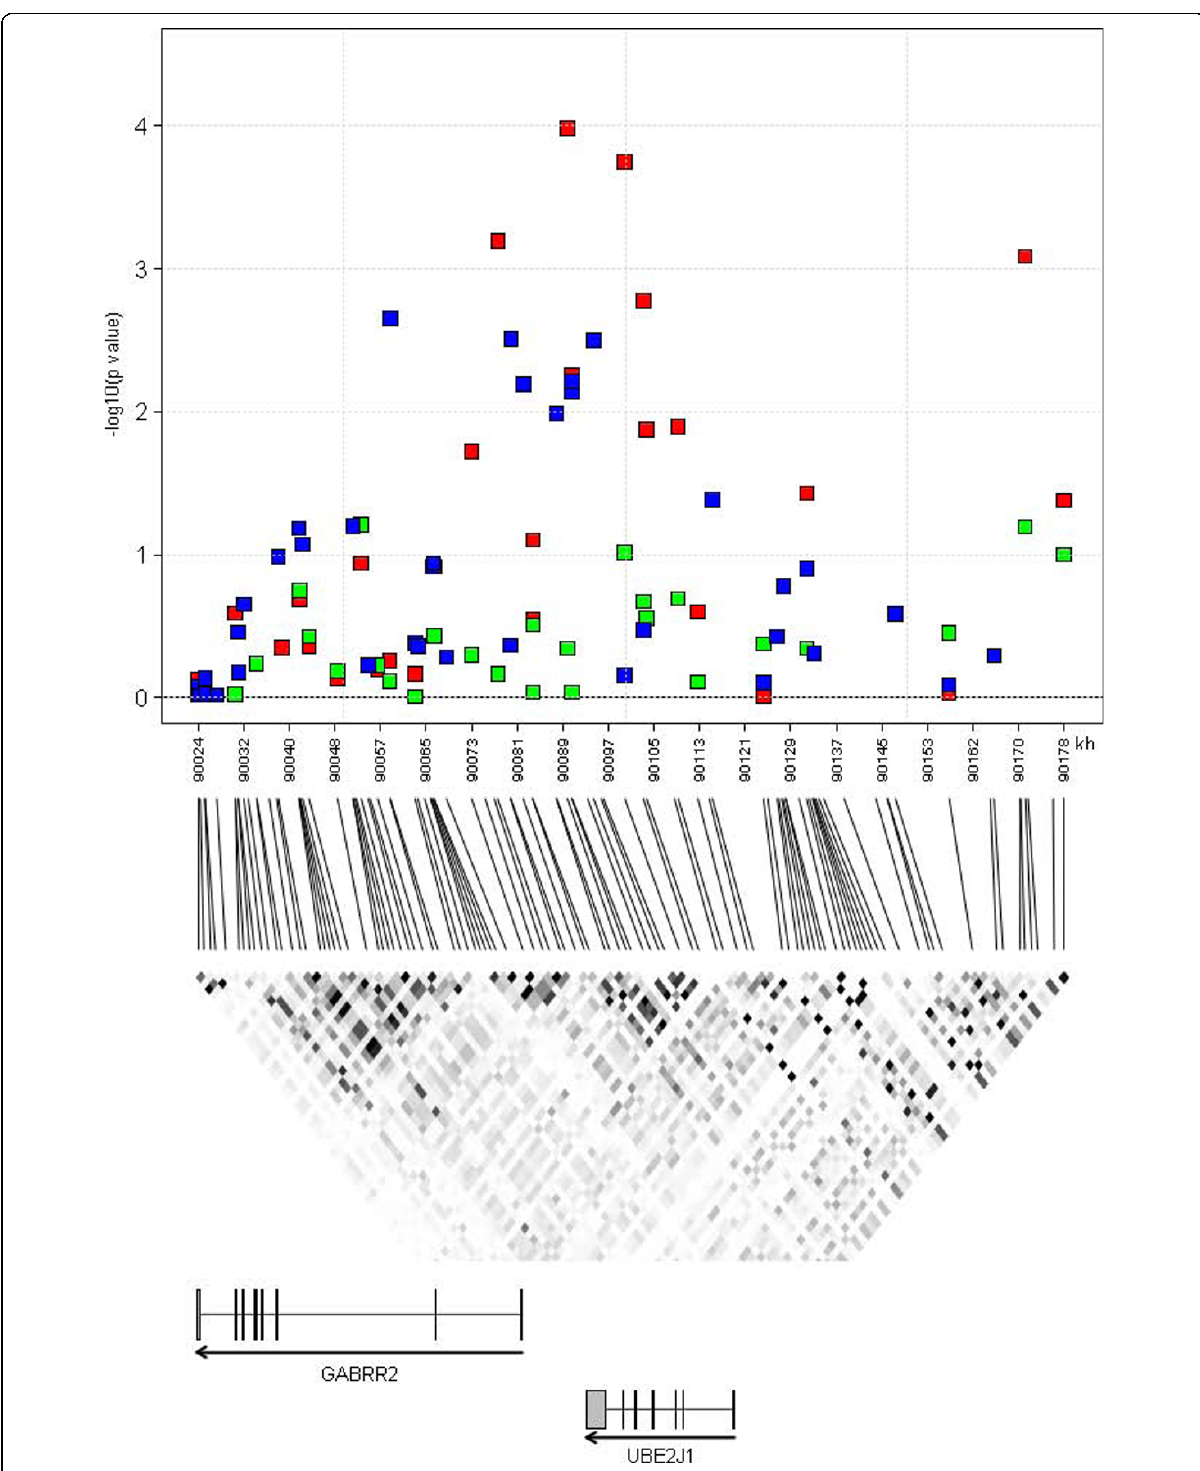
Figure 6 Genomic structure and association results at the GABRR2-UBE2J1 locus . Upper panel : -log 10 (p values) are plotted by physical position for the EUROSPAN discovery meta-analysis (red squares), the popgen (blue squares) and the Korcula (green squares) replication cohorts. Middle panel : linkage disequilibrium (LD) as quantified by r 2 (the higher the LD, the darker the color, with black indicating perfect LD), based upon the HapMap-CEU database, Phase III/Release 2, (NCBI build 36). Lower panel : genes located in the plotted region, with coding exons indicated by black rectangles and